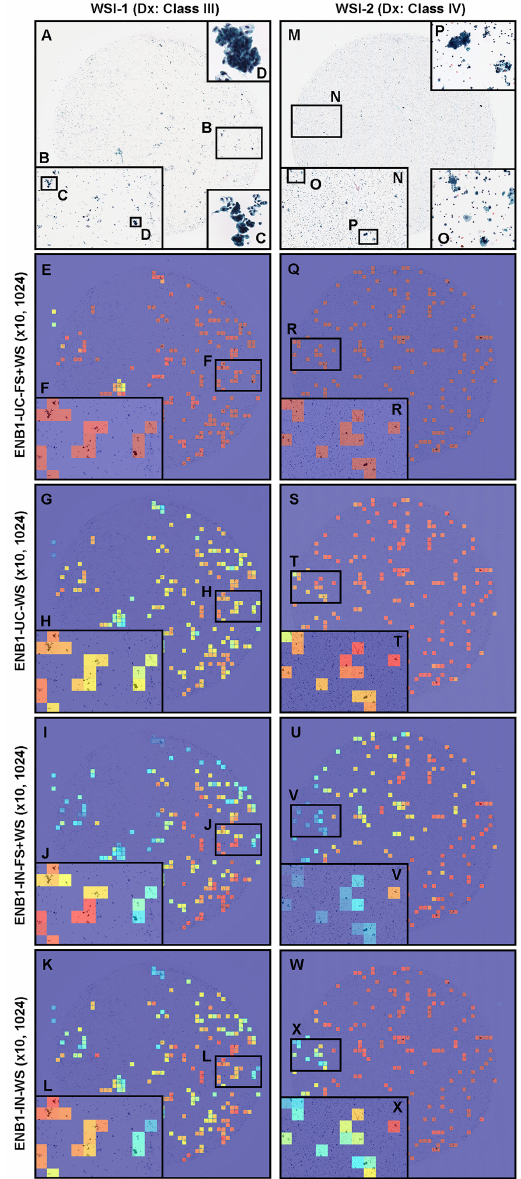
Figure 4. Neoplastic prediction comparison. Comparison of neoplastic predictions in the repre- sentative two neoplastic urine liquid-based cytology (LBC) whole-slide images (WSIs) (WSI-1 and WSI-2) of four trained deep learning models (ENB1-UC-FS+WS, ENB1-UC-WS, ENB1-IN-FS+WS, and ENB1-IN-WS). According to the cytopathological diagnostic (Dx) reports, WSI-1 ( A – L ) was diagnosed as Class III and WSI-2 ( M – X ) was diagnosed as Class IV—both were classified in the neoplastic class in this study. ( A – D , M – P ): LBC cytopathological images for WSI-1 ( A – D ) and WSI-2 ( M – O ); heatmap prediction images for ENB1-UC-FS+WS model in WSI-1 ( E , F ) and WSI-2 ( Q , R ); heatmap prediction images for ENB1-UC-WS model in WSI-1 ( G , H ) and WSI-2 ( S , T ); heatmap prediction images for ENB1-IN-FS+WS model in WSI-1 ( I , J ) and WSI-2 ( U , V ); heatmap prediction images for ENB1-IN-WS model in WSI-1 ( K , L ) and WSI-2 ( W , X ). The localization of predicted tiles in neoplastic WSIs (WSI-1 and WSI-2) were almost same in four models (ENB1-UC-FS+WS, ENB1-UC-WS, ENB1-IN-FS+WS, and ENB1-IN-WS). However, the model pre-trained from uterine cervix LBC model with fully and weakly supervised learning (ENB1-UC-FS+WS) showed the highest neoplastic probabilities ( F , R ) in neoplastic tiles ( B – D , N – P ) as compared to other models ( G – L , S – X ). The heatmap uses the jet color map where blue indicates low probability and red indicates high